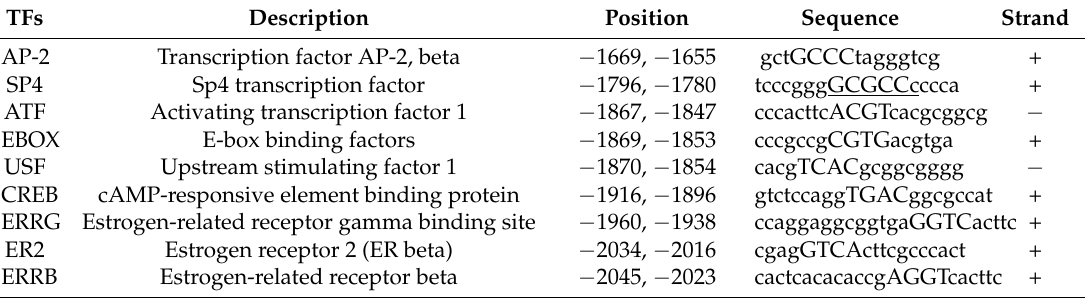
Table 2. Identification of the putative cis-regulatory elements upstream of ovine growth differentiation factor 9 ( GDF9